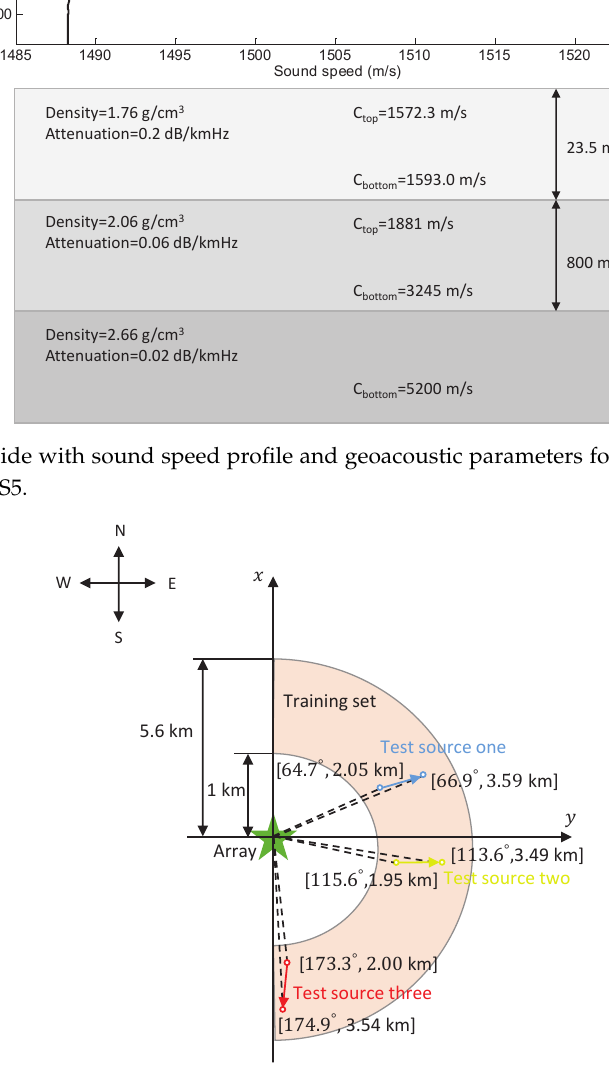
Figure 8. The map of source movement and the location of the hydrophone array in the simulation. The semi-annular orange region covers the ranges of training sources’ motions. The training data included sources with azimuth angles from 0 ◦ to 180 ◦ with 5 ◦ intervals (the course equals to azimuth angle). In each azimuth angle, the source was ranging from 1.0 to 5.6 km at a speed of 5 knots (2.5 m/s). The blue, yellow, and red lines were the trajectories of test source one, two, and three. The array includes two topologies, including HCA and HLA. The HCA was 50-element with a 250 m radius, where the hydrophones were uniformly distributed. The HLA was 27-element, the layout of which is the same as the HLA North of SWellEx-96 Event